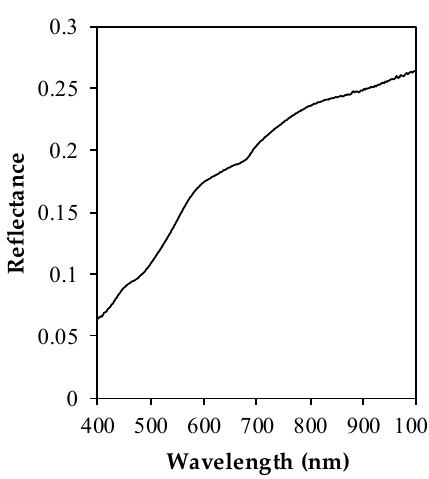
Figure 1. The soil reflectance used for the PROSAIL simulations.